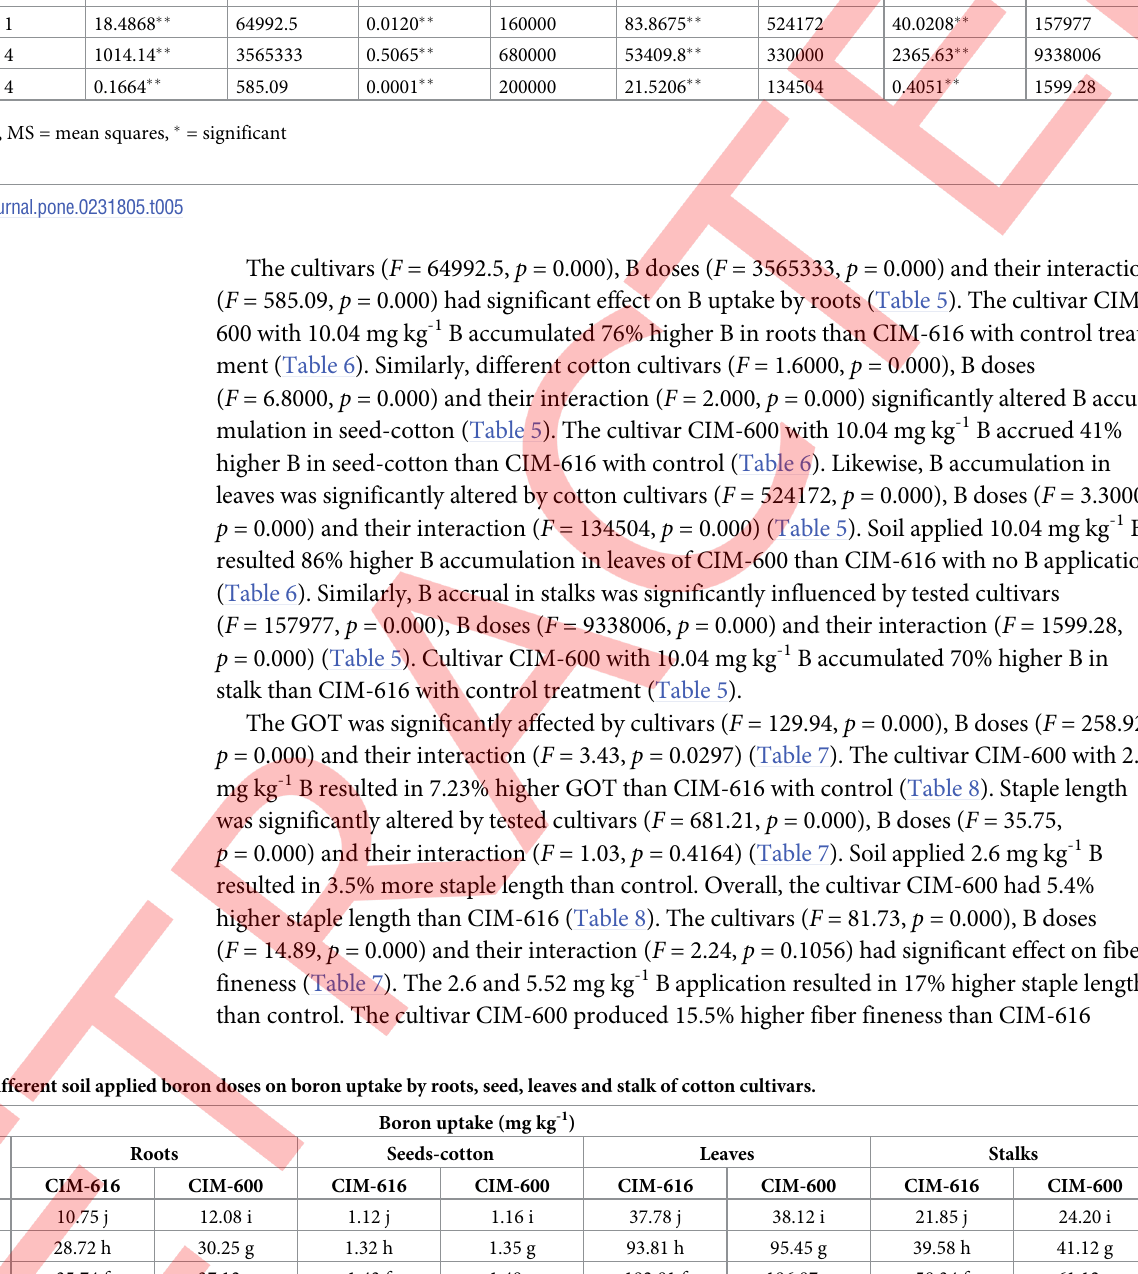
Table 5. Analysis of variance of different soil applied boron doses on boron uptake by roots, seed, leaves and stalk of cotton cultivars. SOV DF Boron uptake by roots (mg kg - 1 )